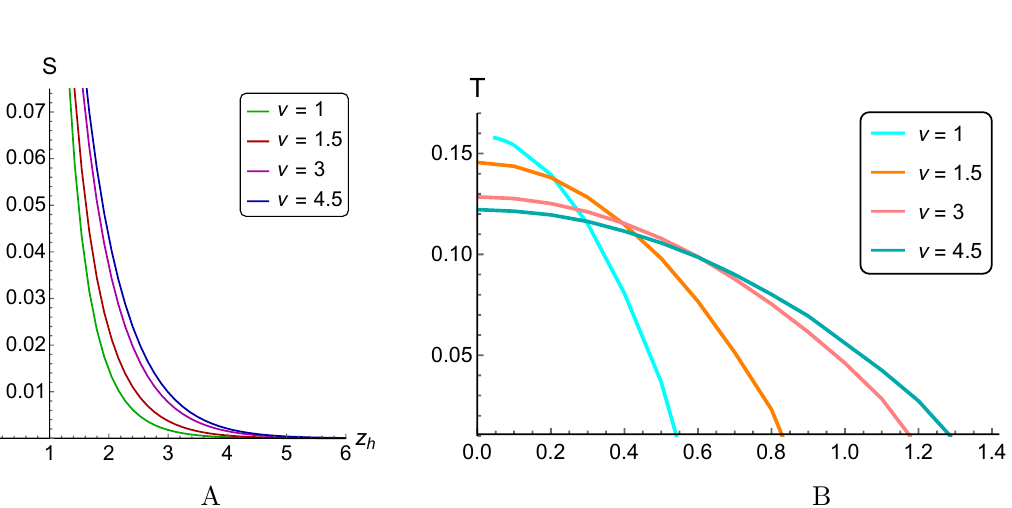
Figure 13 . Entropy as function of horizon (A) and Hawking-Page-like phase transition lines T ( µ ) for isotropic ( ν = 1 ) and anisotropic ( ν = 1 . 5 , 3 , 4 . 5 ) cases (B); a = 4 . 046 , b = 0 . 01613 , c = 0 . 227 .